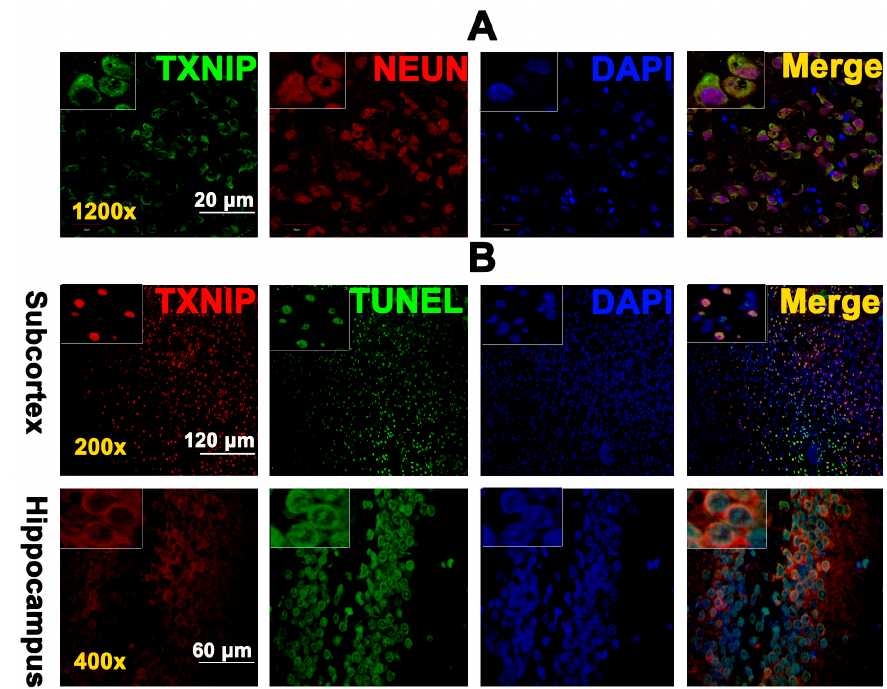
Figure 3. The histological fluorescent analysis of TXNIP and immunofluorescence Terminal dexynucleotidyl transferase (TdT)-mediated dUTP nick end labeling (TUNEL) staining with